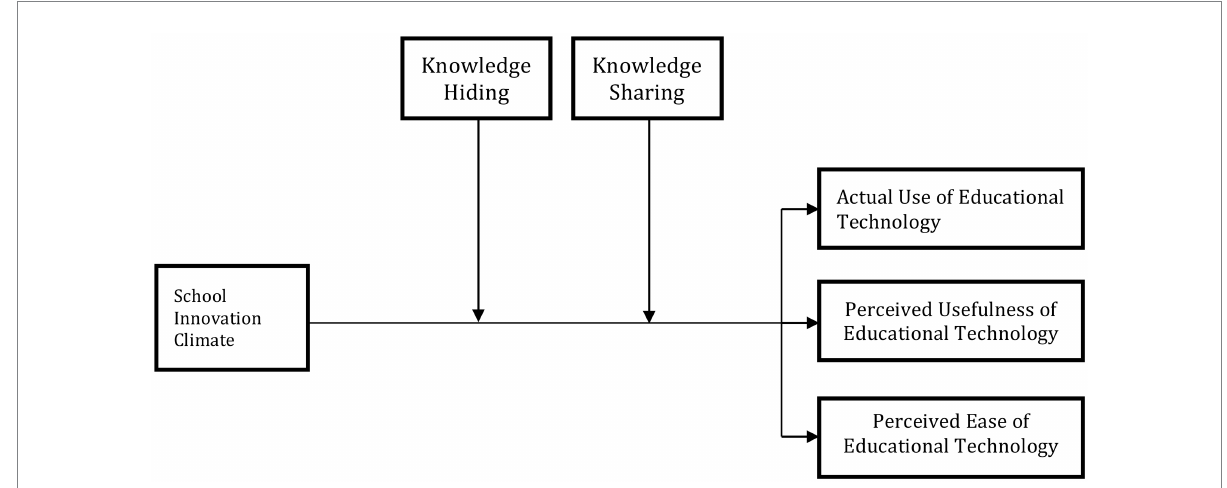
FIGURE 1 Theoretical framework of the